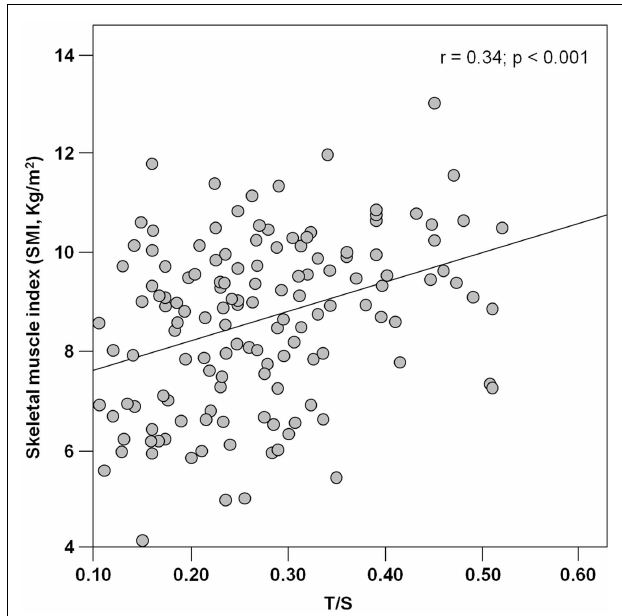
FIGURE 1 | Scatter plot of telomere/single-copy gene ratio ( T/S ) and the skeletal muscle index ( n = 142) .